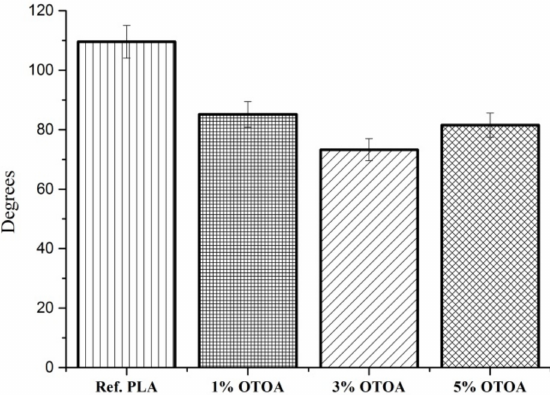
Figure 7. Water contact angle for nonwoven PLA materials: pristine PLA, PLA + 1% OTOA, PLA + 3% OTOA, PLA + 5%